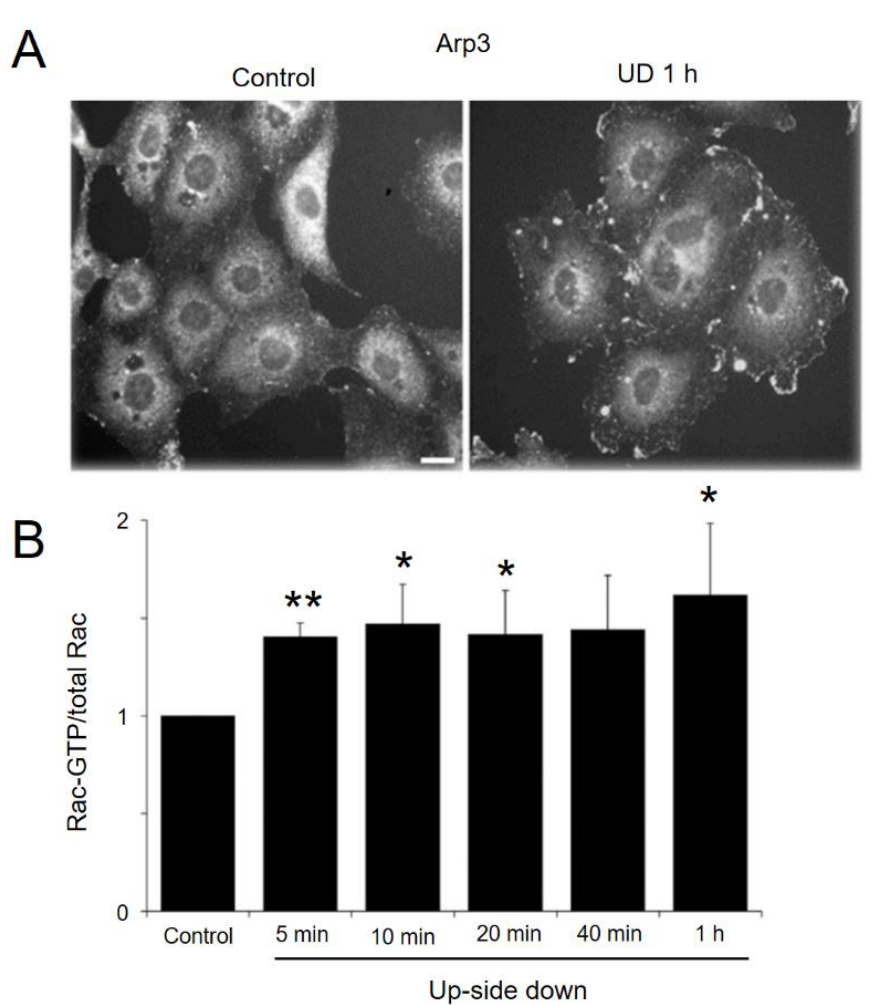
Figure 4. Increased lamellipodia formation in upside-down cells. ( A ) BAECs cultured right-side up ( left ) or upside down ( right ) for 1 h were stained with anti-Arp3. Note the extensive lamellipodia formation in upside-down cells. Scale bar 10 µ m. ( B ) Active Rac1 (i.e., GTP bound Rac1) was quantified by the Li-Core system as described in the Methods section. Increased levels of active Rac1 in upside-down cells are shown. Mean values with standard error of the mean obtained from six independent measurements are shown. p -values were calculated by t -test between values of time 0 and values of each time point. * p < 0.05, ** p < 0.001.